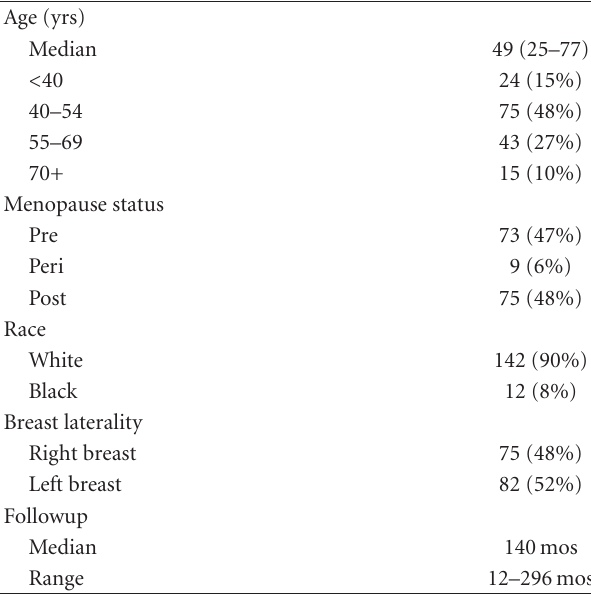
Table 1: Characteristics of 157 patients at time of initial